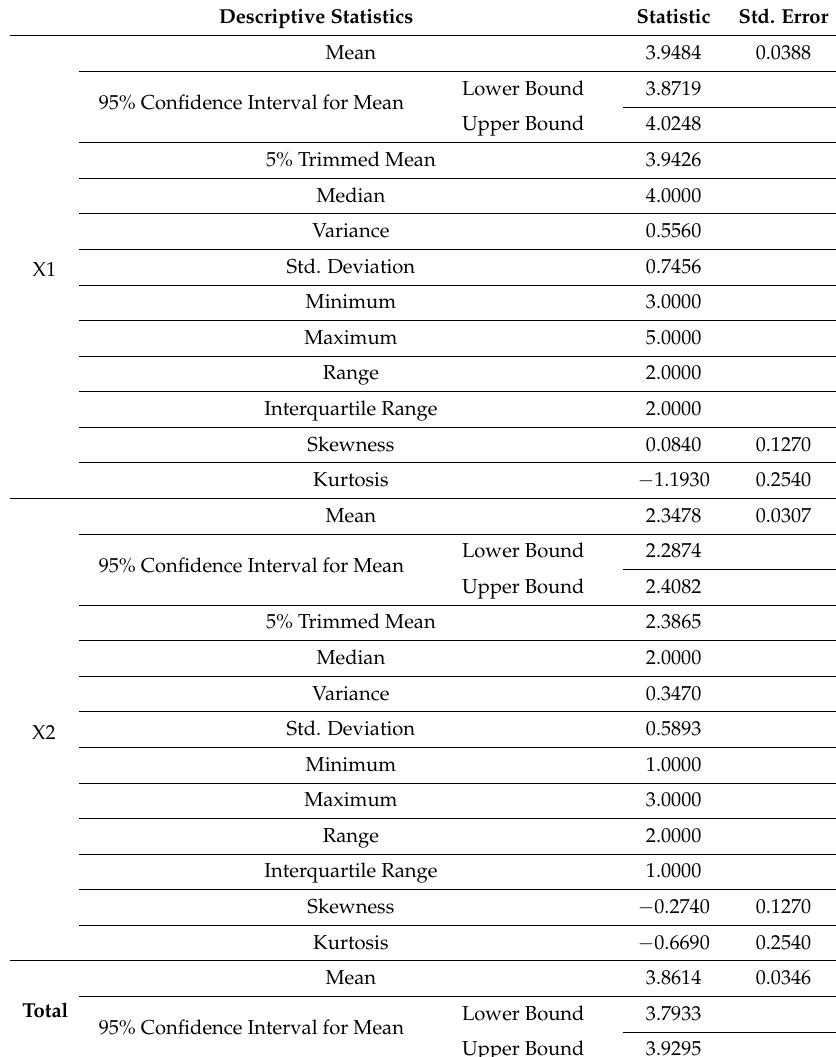
Table 4. Descriptive statistics of